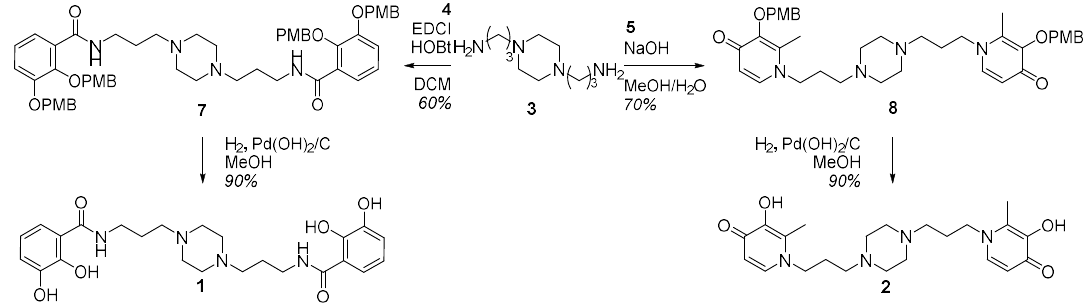
Figure 4. Synthesis of the iron chelators bearing catecholate ( 1 ) or hydroxypyridinone ( 2 ) moieties.